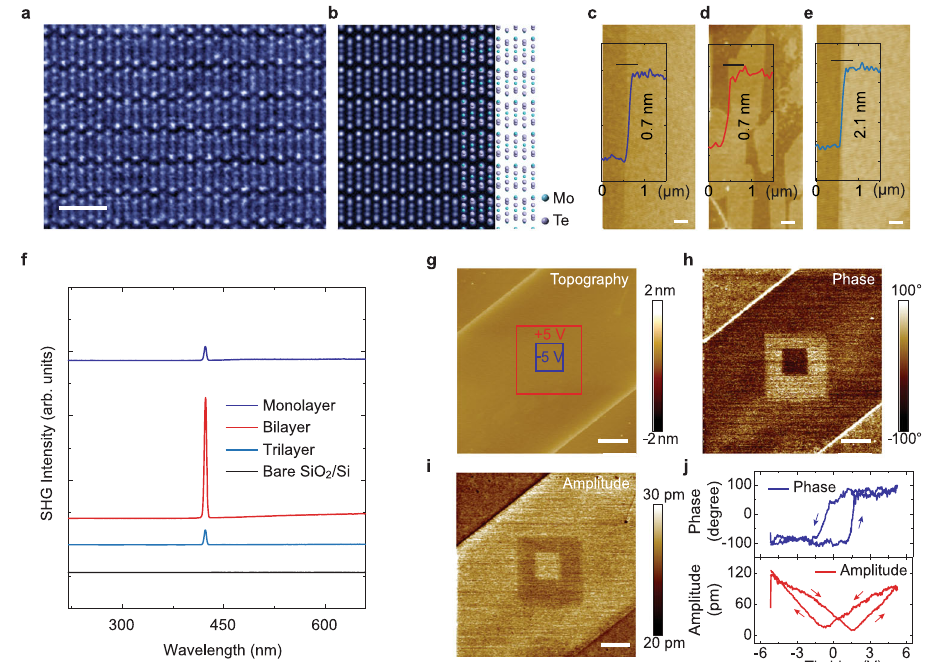
Fig. 2 | Atomic structure and layer-dependent inversionsymmetry breaking of MoTe 2 fi lm. a,b Aberration-corrected scanning transmission electron microscopy images ( a ) and corresponding simulated atomicstructure( b ) of bilayer1T ′ MoTe 2 . Thescalebaris1nm. c – e Atomicforcemicroscope imagesofMoTe 2 withdifferent layers, showing the thickness of monolayer with 0.7nm ( c ), epitaxially grown 0.7nm-thicksecondlayerontopofthemonolayer( d ),and2.1nm-thicktrilayer( e ). All the scale bars are 1 μ m. f , Second-harmonic generation measurement of MoTe 2